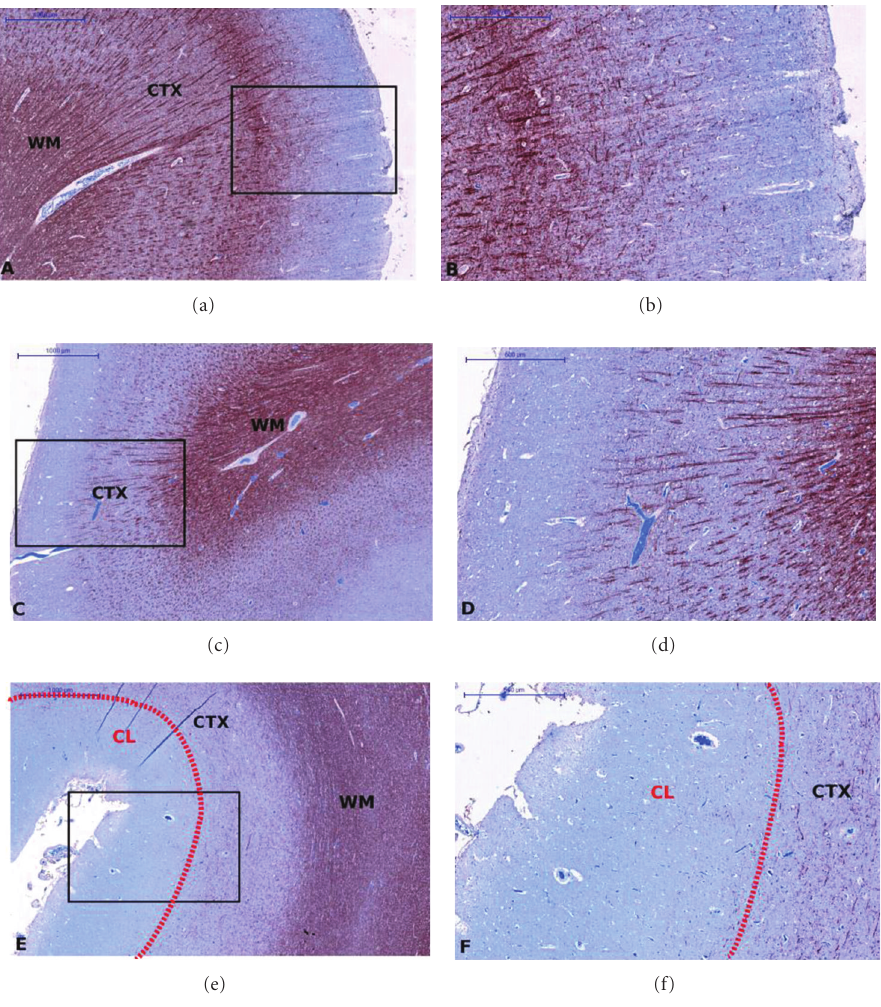
Figure 3: GM sections immuno-stained against MBP. The rectangles in the MBP sections in the left column are magnified in the right column. ((a)-(b)) represent healthy cortex, ((c)-(d)) NAC, and ((e)-(f)) a demyelinated type III subpial CL delineated by the dotted red line. Left column ((a), (c), (e)) bar = 1000 μ m, right column ((b), (d), (f)) bar = 500 μ